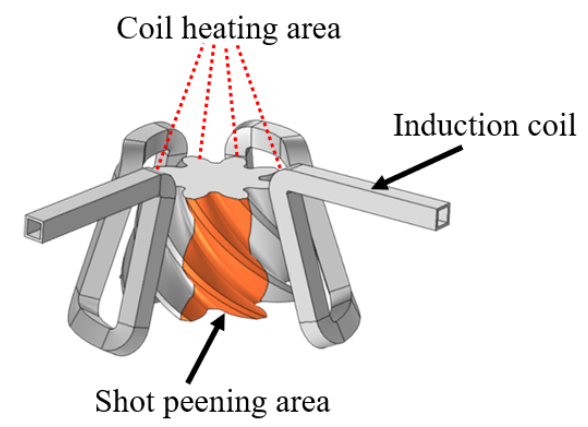
Figure 6. Division of gear research area.